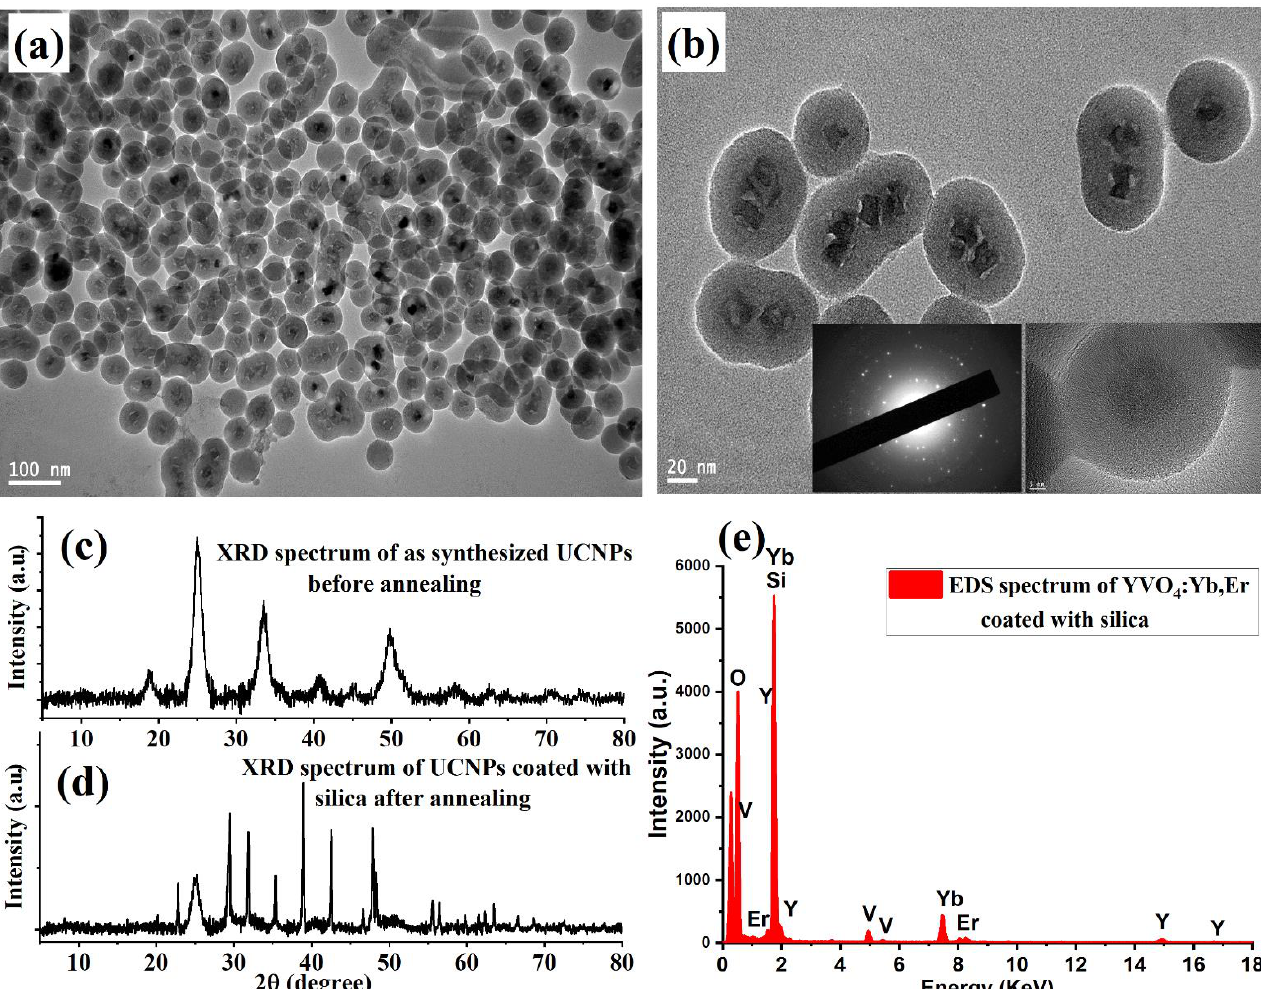
Figure 2. Structural analysis and characterization of YVO 4 :Yb, Er UCNPs. ( a ) Low magnification TEM image of well-crystalline and small size UCNPs obtained by the protected calcination process. ( b ) High magnification of the synthesized UCNPs. ( c , d ) XRD data of UCNPs before and after high-temperature treatment. ( e ) Energy-dispersive X-ray (EDX) spectrum recorded and analyzed from the synthesized UCNPs.